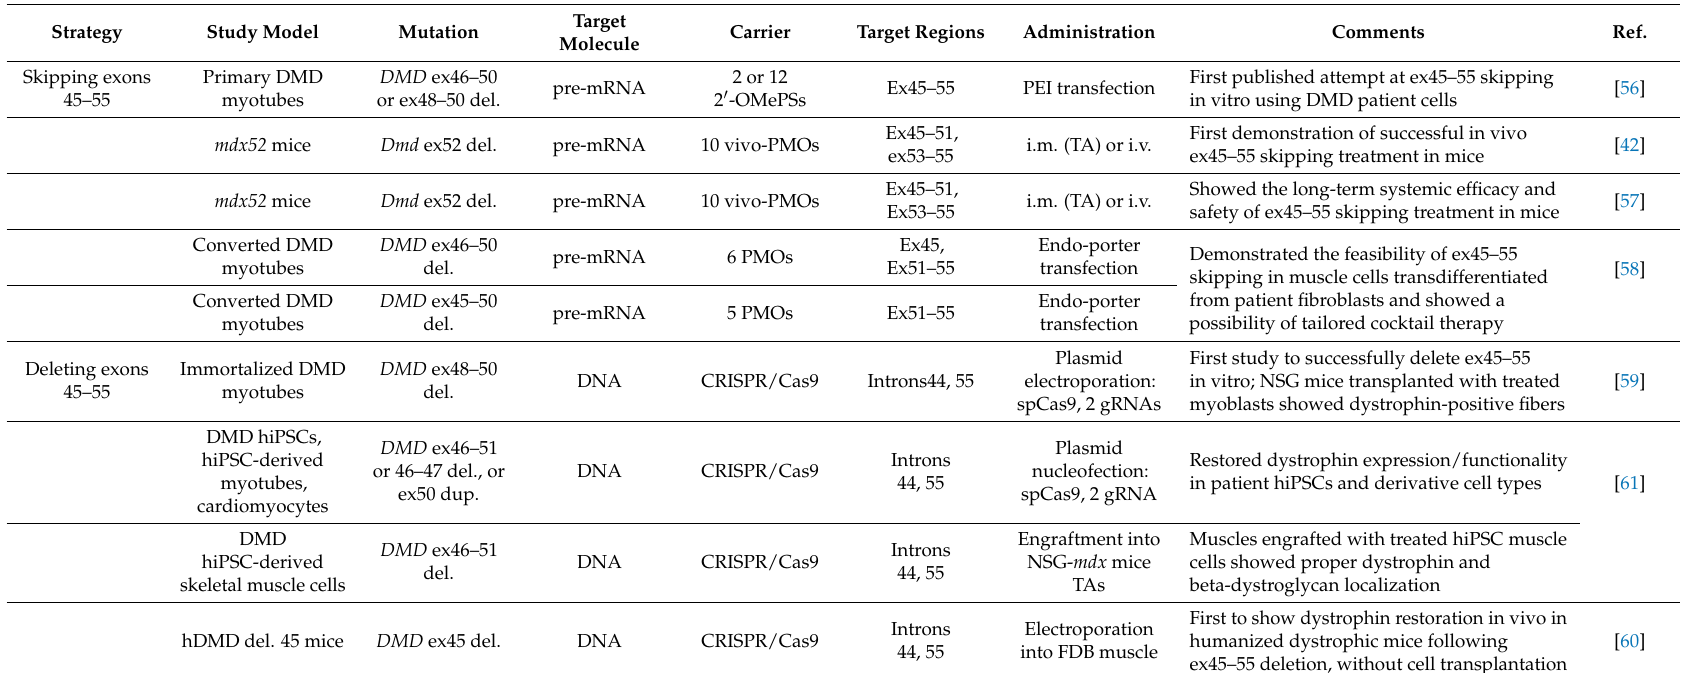
Table 1. Pre-clinical studies with skipping or deleting the exons 45–55 region in the distal hot